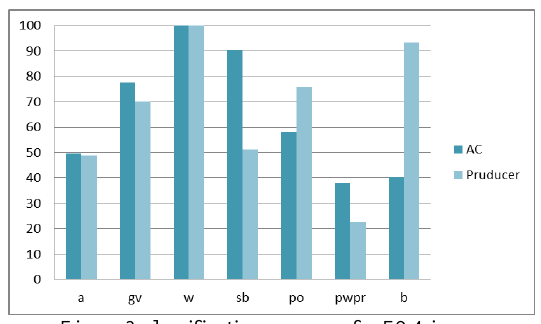
Figure 5 the overall classification accuracy in all three